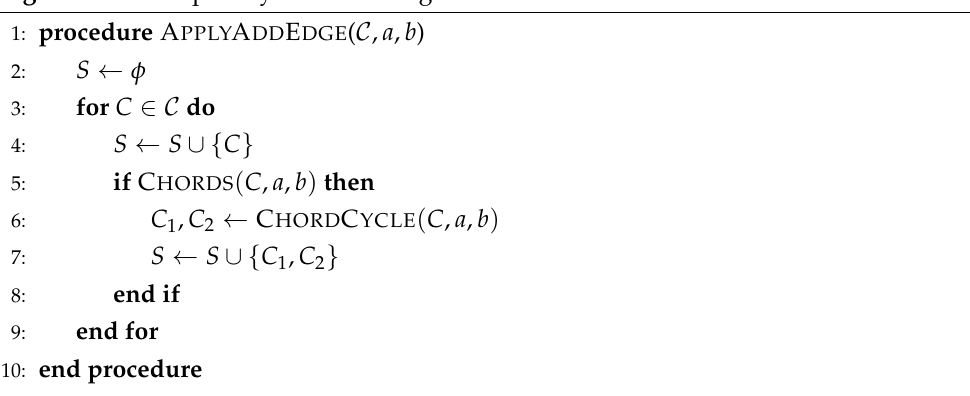
Algorithm 1 Compute cycles for an edge addition